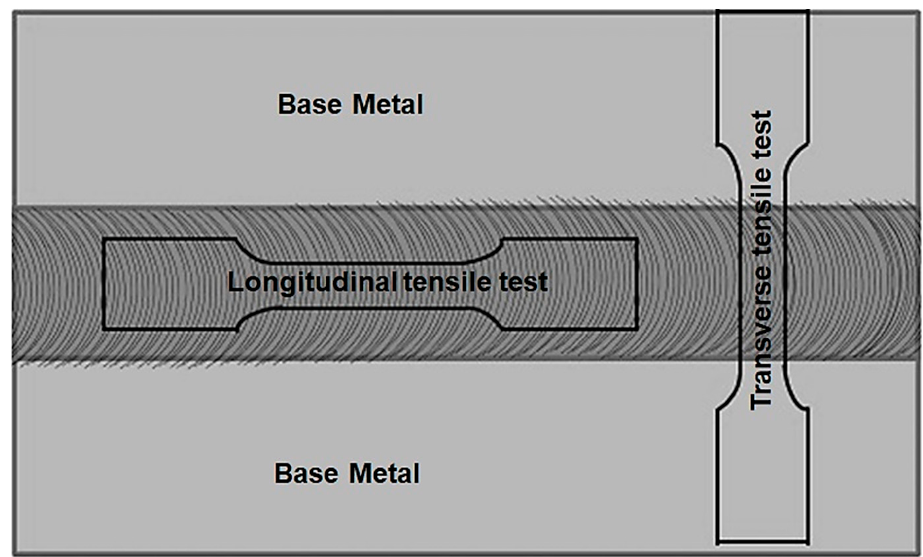
Figure 17. Schematic of the locations from which longitudinal and transverse tensile test specimens are cut.